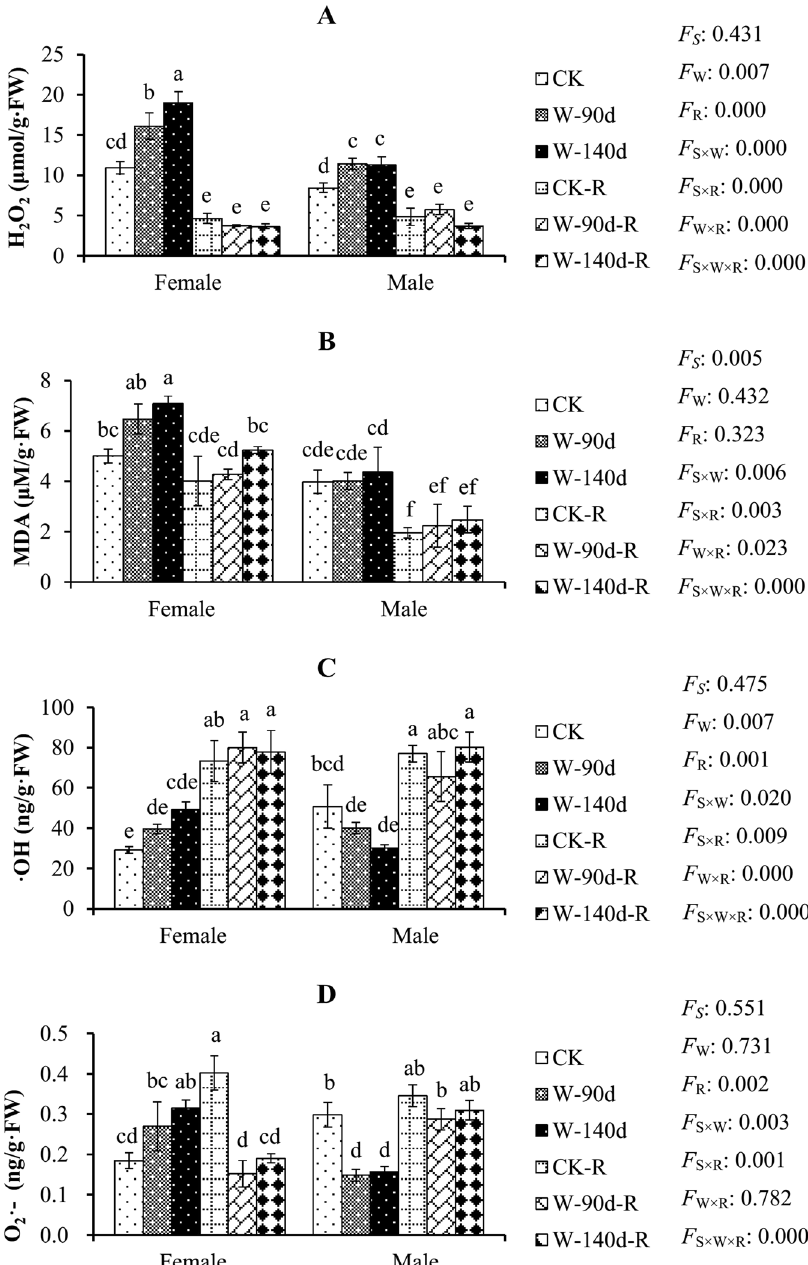
Figure 5. Hydrogen peroxide (H 2 O 2 ), malondialdehyde (MDA), hydroxyl radical (·OH), and superoxide radical (O 2 . − ), content variations in male and female P. deltoides under winter flooding stress and post-flooding recovery. CK, control treatment; W, flooding and waterlogging stress treatment; R, recovery after waterlogging stress. Values are means ± SE ( n = 5). Letters above the columns indicate significantly differences at P < 0.05 according to Duncan’s test. The significance values of the factorial analysis (ANOVA) for: F S , F W , and F R refer different effects of species, watering, and recovery growth, respectively; F S × W , F S × R , F W × R , and F S × W × R refer species × watering effects, species × recovery growth effects, watering × recovery growth effects, and species × watering × recovery growth effects,